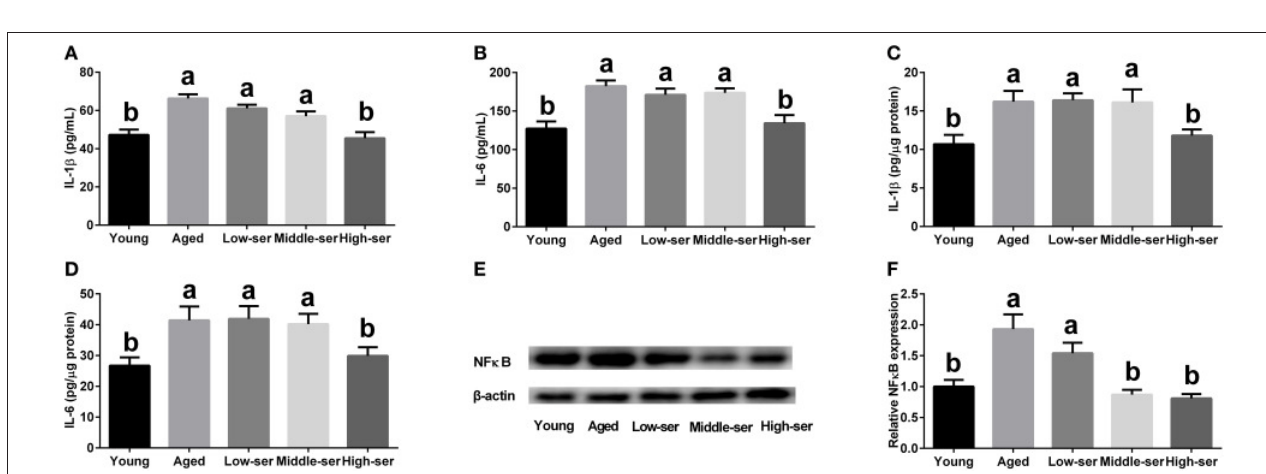
FIGURE 4 | Effects of long-term L -serine administration on the inflammatory response in aging mice. (A,B) Concentrations of IL-1 β and IL-6 in serum; (C,D) Concentrations of IL-1 β and IL-6 in the hypothalamus; (E,F) Relative NF- κ B protein expression. Aged, untreated control mice; Low-ser, mice supplemented with 0.1% (wt/vol) L -serine dissolved in the drinking water; Middle-ser, mice supplemented with 0.2% (wt/vol) L -serine dissolved in the drinking water; High-ser, mice supplemented with 0.5% (wt/vol) L -serine dissolved in the drinking water. Young, adult male mice at the age of 18 months. Values are expressed as mean ± SEM, n = 3 for the statistical analysis of western blotting data and n = 8 for the statistical analysis of other data; a,b Means of the bars with different letters were significantly different among groups ( P <